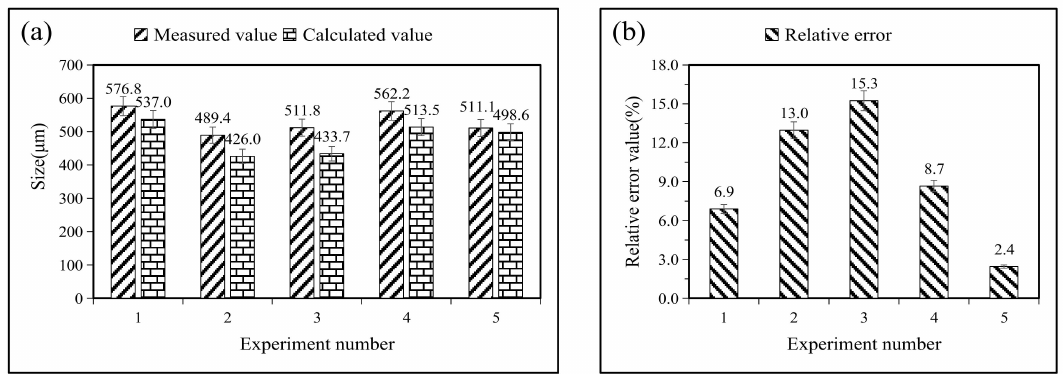
Figure 15. Error verification of Equation (11) (( a ). comparison of measureed value and calculated value; ( b ). corresponding relative error).